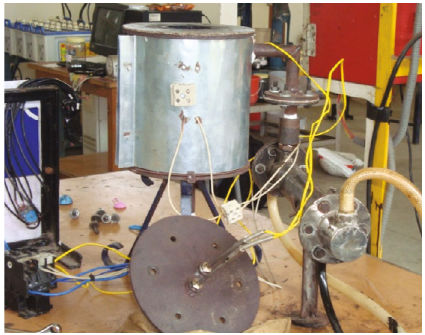
Figure 1: Reactor setup. Table 1: Feedstock